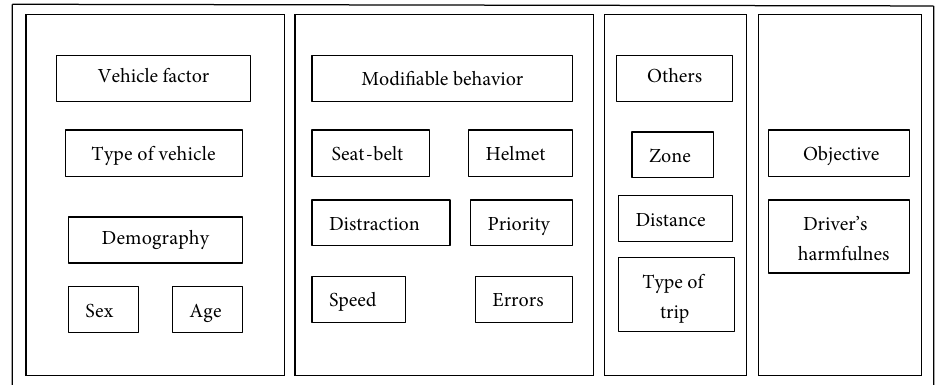
Figure 2: Theory model.